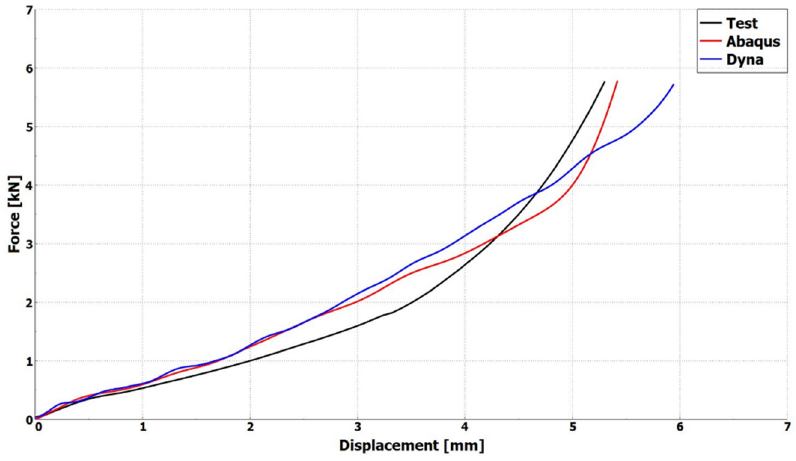
Figure 15. Force-displacement curves of the cell load-case radial crush impactor.